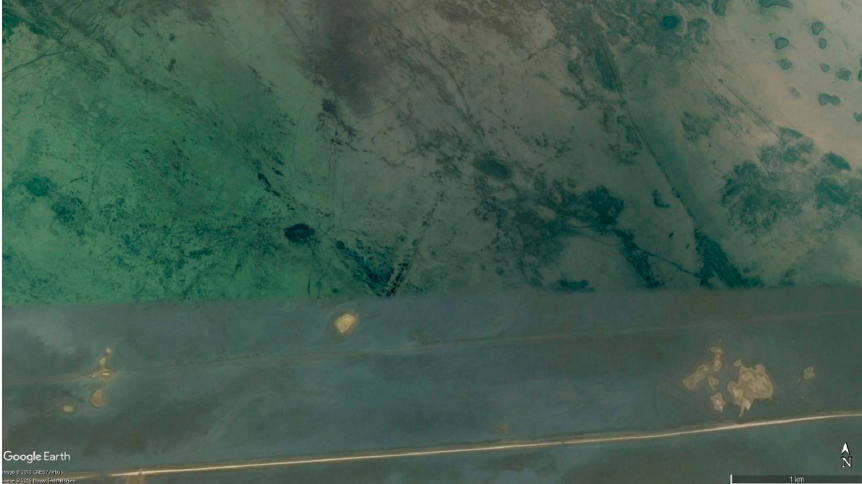
Figure 17. In some places, hollow ways could be seen to end abruptly where a newer, clearer image abutted an older, blurrier image. As imagery is updated, it is expected that more hollow ways will become